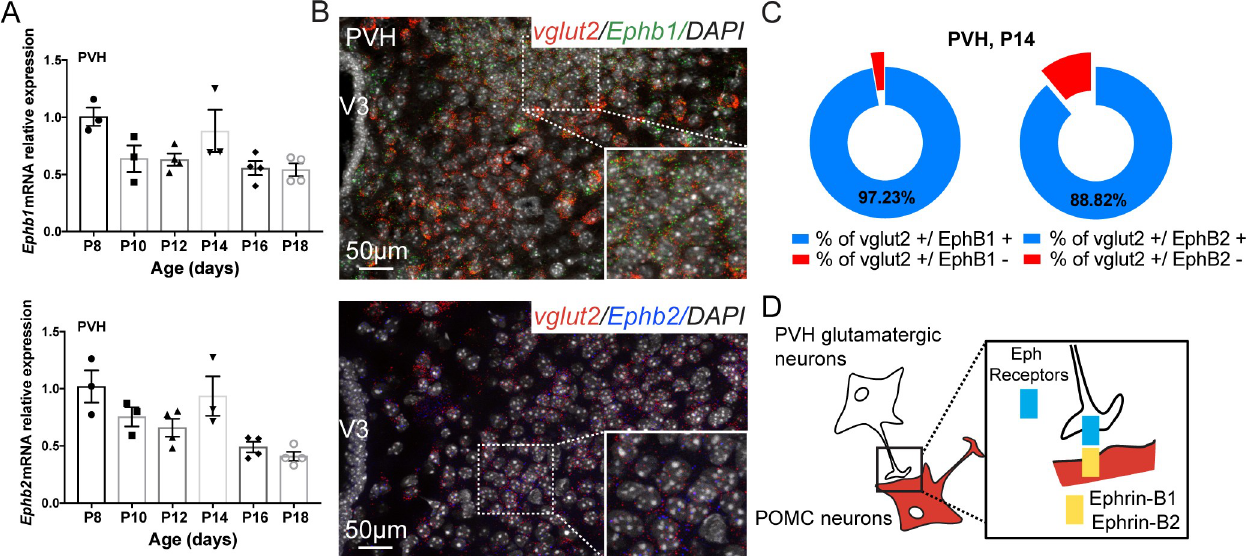
Fig 2. EphrinB signaling. (A) Quantification of Ephb1 and Ephb2 mRNA relative expressions in the PVH of P8 to P18 male mice ( n = 3–4/group). Photomicrographs (B) and quantification (C) showing co-expression of Ephb1 (green) and Ephb2 (blue) mRNA with vglut2 mRNA (red, glutamatergic marker) in the PVH of P14 male mice. DAPI counterstaining is shown in white. (D) Schematic of our working model. Data are shown ± SEM. Statistical significance was determined using 1-way ANOVA (A). The underlying data are provided in S1 Data. ANOVA, analysis of variance; POMC, proopiomelanocortin; PVH, paraventricular nucleus of the hypothalamus; SEM, standard error of the mean; V3, third ventricle.